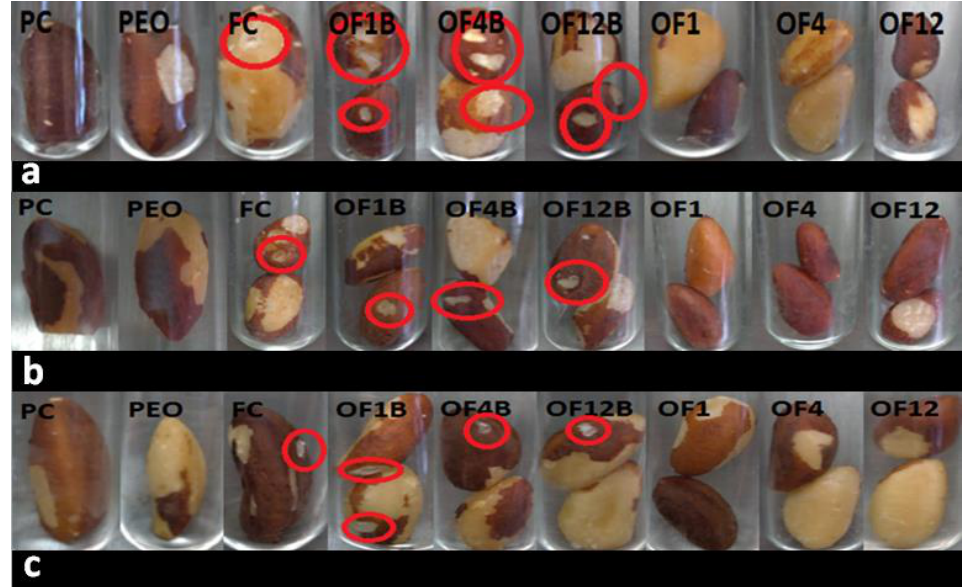
Figure 4. In situ antifungal activity with Brazil nuts. ( a ): 30th day of stability (10th day after treatment); ( b ): 60th day of stability (10th day after treatment); ( c ): 90th day of stability (10th day after treatment). PC: positive control (Carbendazim at 250 µg mL −1 ); PEO: non-encapsulated Palmarosa essential oil (250 µg mL −1 ); FC: fungal control; OF1B: blank optimized formulation 1; OF4B: blank optimized formulation 4; OF12B: blank optimized formulation 12; OF1: optimized formulation 1; OF4: optimized formulation 4; OF12: optimized formulation 12.